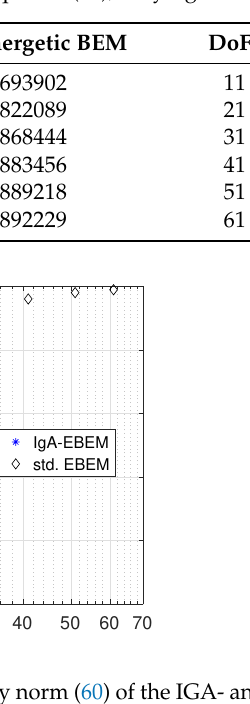
Table 5. Space-time energy norm squared (60), varying d and fixing ∆ t = 2 − d ∆ x .